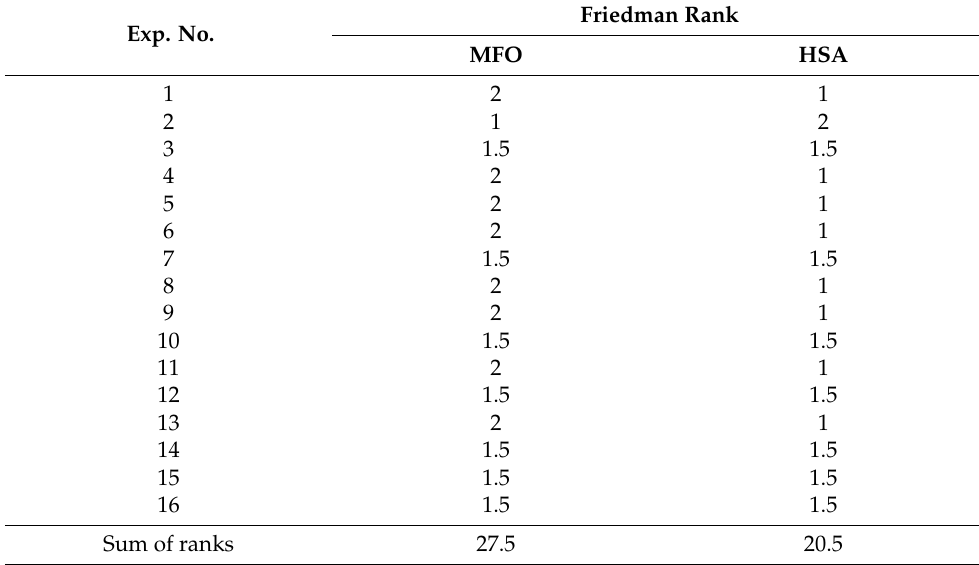
Table 15. Friedman rank details.